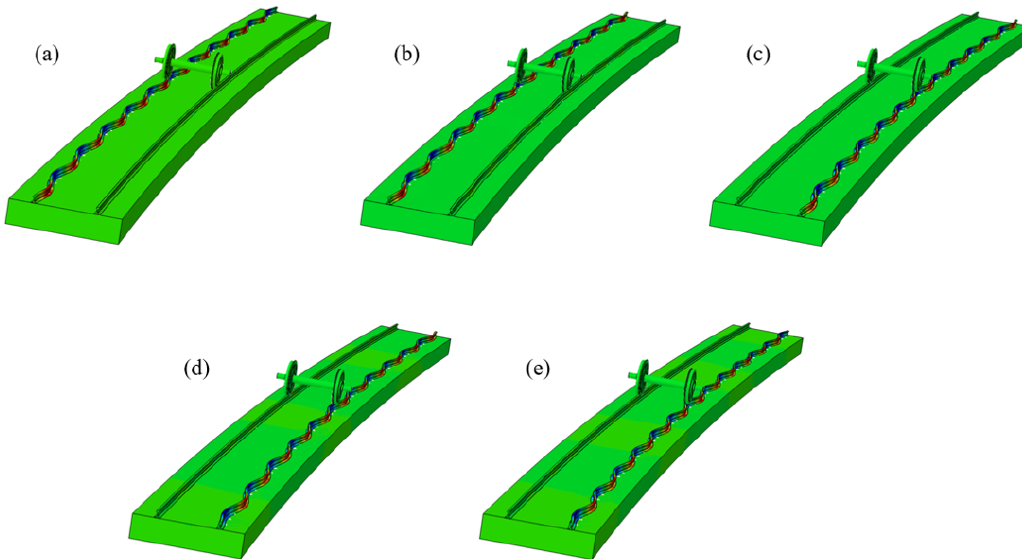
Figure 9. Dominant mode diagrams. (a) Deficient superelevation: 20mm. (b) Deficient superelevation: 10mm. (c) Balanced superelevation. (d) Excess superelevation: 10mm. (e) Excess superelevation: